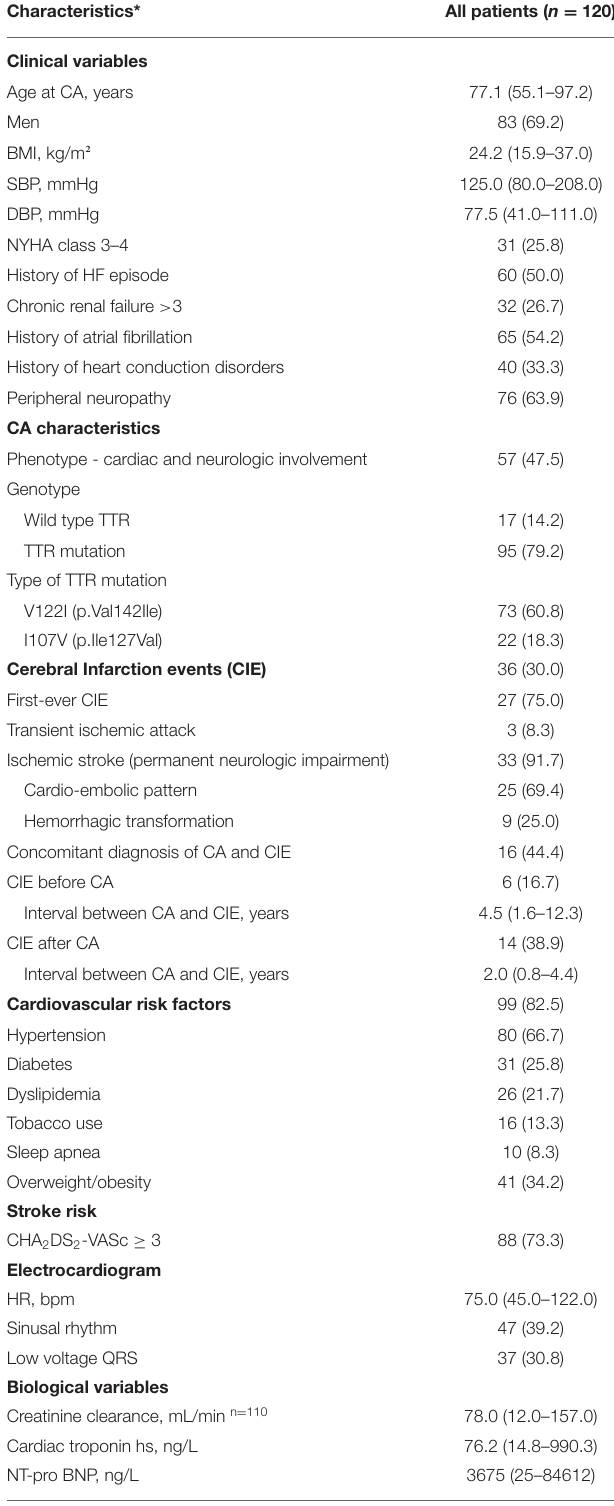
TABLE 1 | Main characteristics of 120 patients diagnosed with transthyretin cardiac amyloidosis between July 2005 and October 2019.